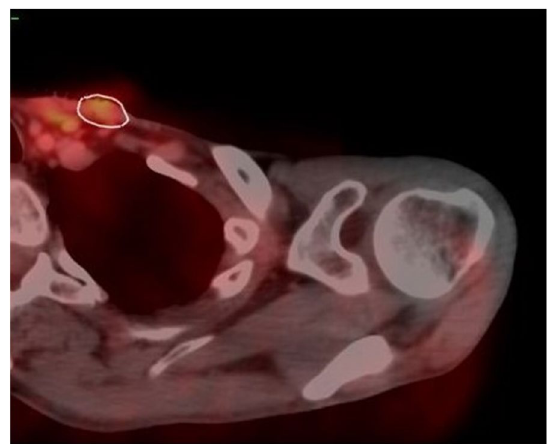
Fig. 4 WB PET CT showing FDG avid metastatic skin nodule (white)